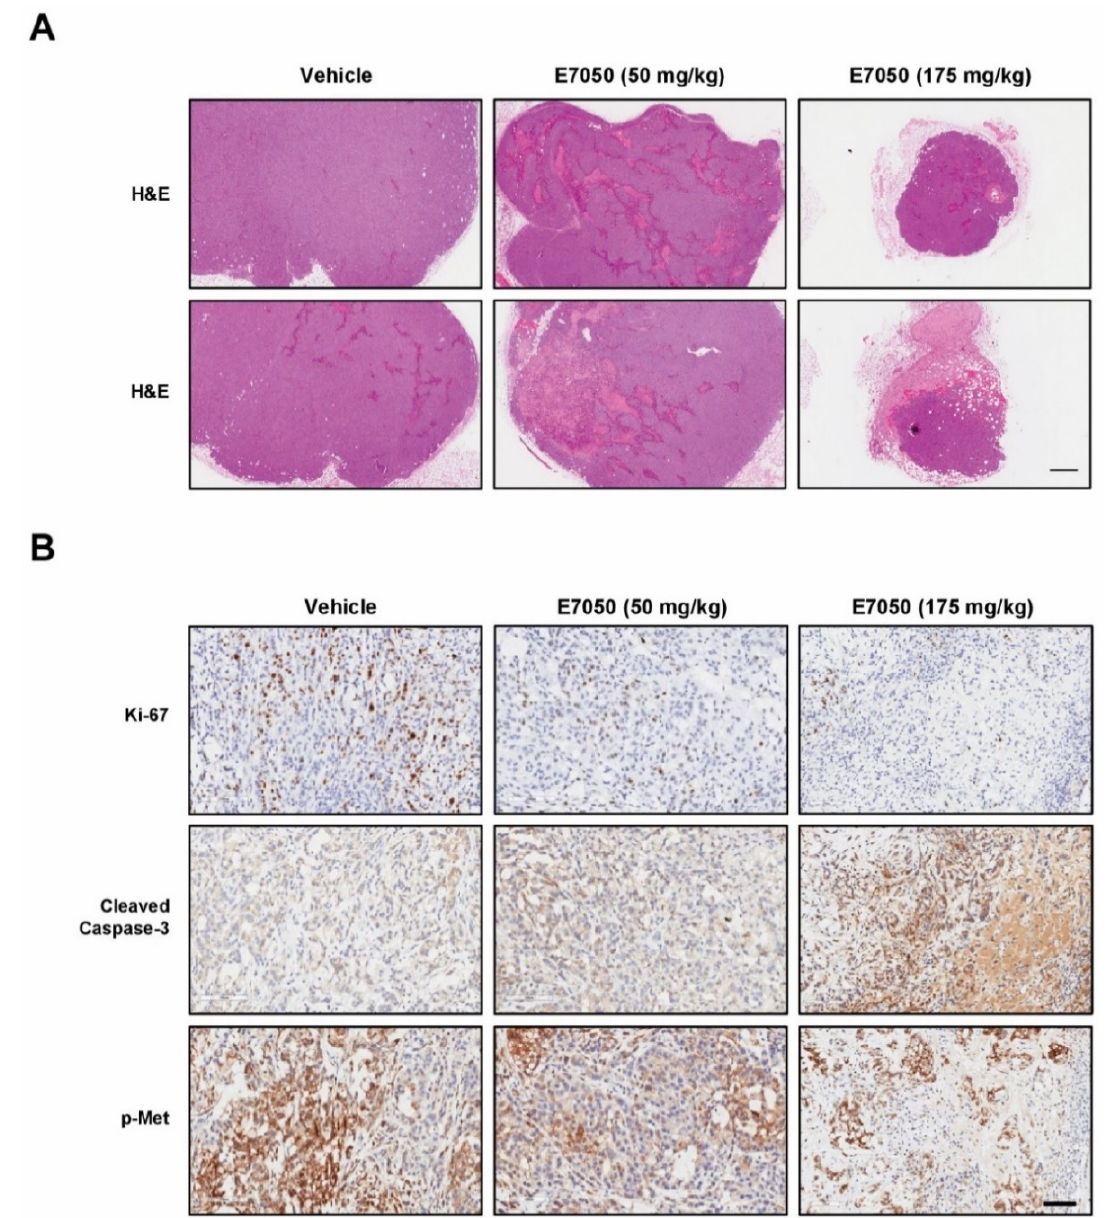
Figure 7. Effects of E7050 on histology and the expression levels of caspase-3 p17, Ki-67 and p-Met in tumor tissue sections obtained from MES-SA/Dx5 cell line-derived xenografts. ( A ) Representative photographs of tumor tissue sections from each group stained with H&E. Scale bar, 500 µm. ( B ) Immunohistochemical analysis was used to analyze cell proliferation marker Ki-67, apoptosis marker cleaved caspase-3 and p-Met expression in tumors. Representative images of tumor cells that stained positive for Ki-67, cleaved caspase-3 and p-Met in tumor tissue sections from control and treated groups are shown. Scale bar, 100 µ